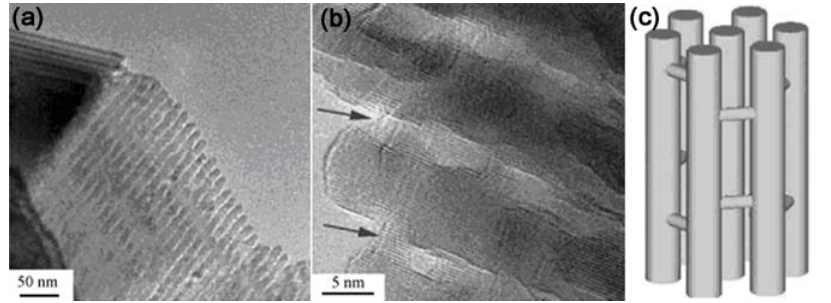
Figure 2. (a) TEM image of the 3D Cr with higher magnification showing the ordering of the Cr indicate the bridges. (c) Schematic drawing of the structure of 3D Cr crystals [99]. (Reproduced by the permission of the Royal Society of Chemistry.)